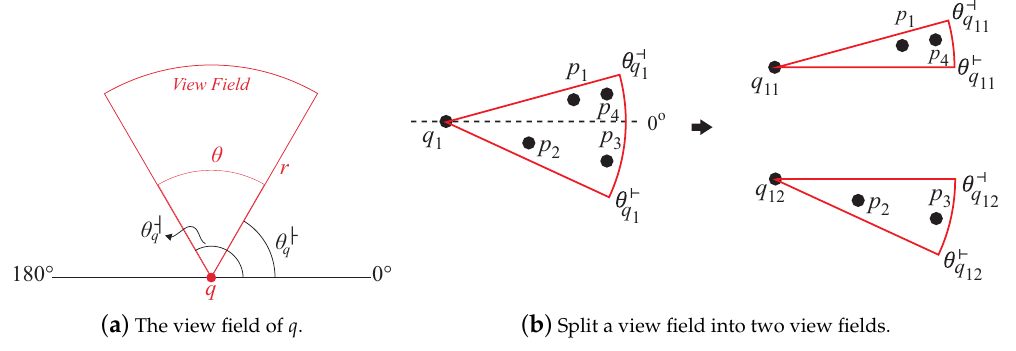
Figure 5. The view field.